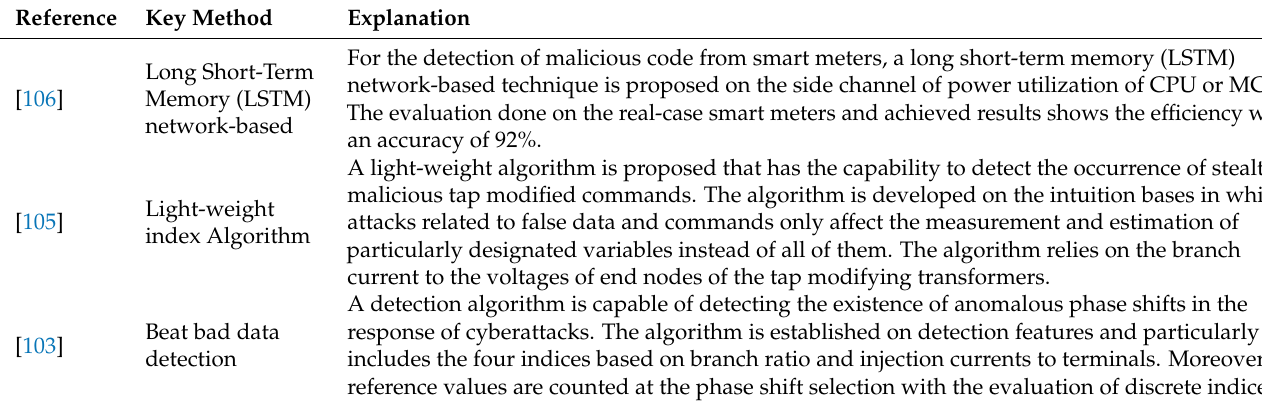
Table 7. Methods and countermeasures to defend against MCI Attack.